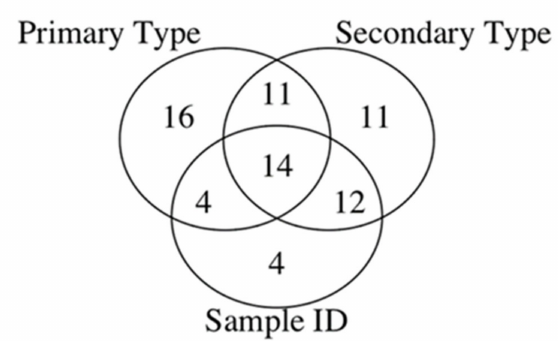
Figure 3. Venn diagram of py-MBMS spectral ion feature sets us RUV corrected spectra for different classification levels of biomass